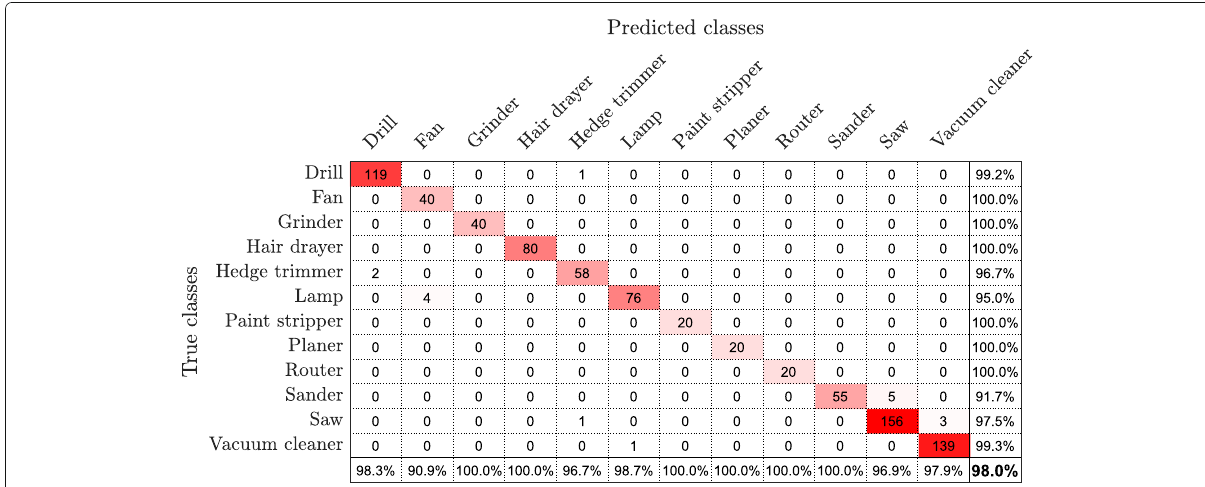
Fig. 18 Classification result as a confusion matrix using the minimum radius of curvature R min and model parameters ˆ a i . The bottom rightmost cell gives the classification rate, the rightmost column contains the recall values, and the bottom row the precision